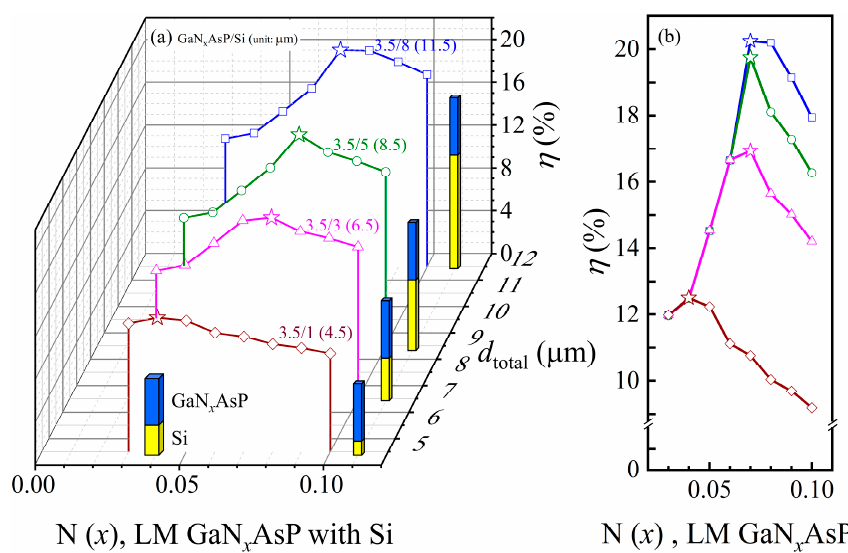
Figure 6. ( a ) PCEs ( η ) of the lattice-matched GaN x AsP/Si tandem cell as a function of N concentration ( x ) with the different total thickness ( d total ). The schematics of the tandem cell are plotted in the figure. The thickness of each cell is labeled above the curve; ( b ) PCEs of GaNAsP/Si tandem cell as a function of nitrogen concentration ( x ).